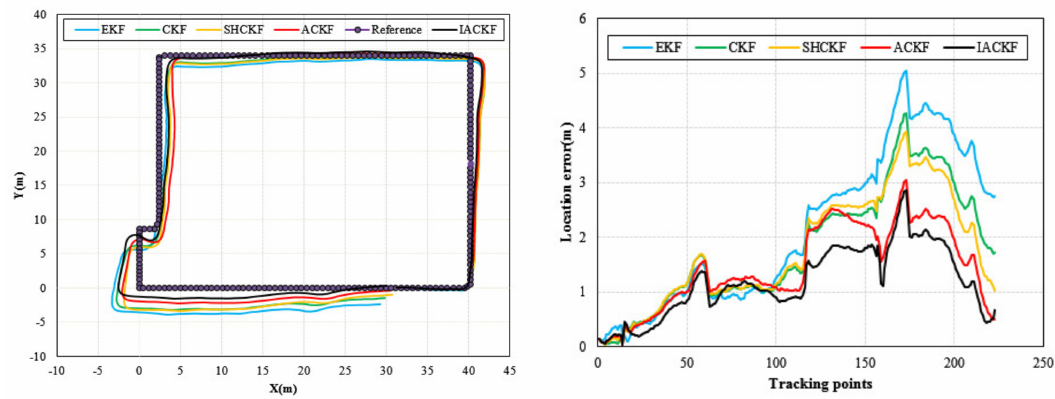
Figure 13. Distributions of different